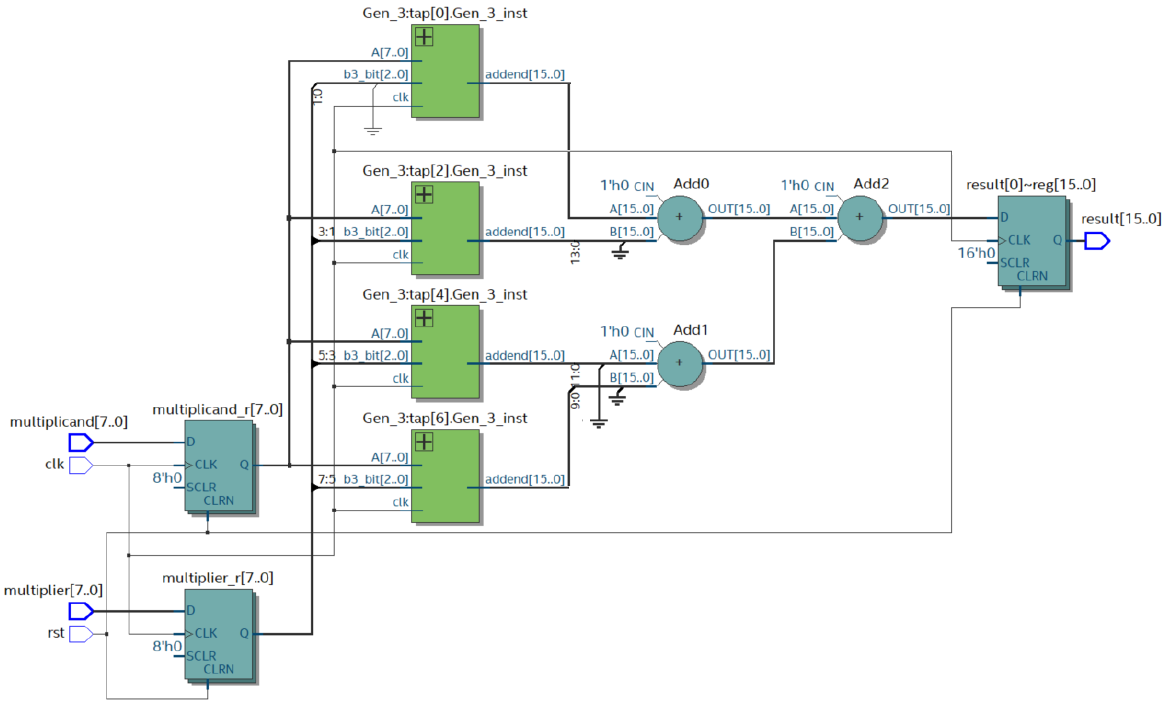
Figure 5. Multiplier test setup: ( a ) multiplier of two signals, ( b ) multiplier of signal by constant.